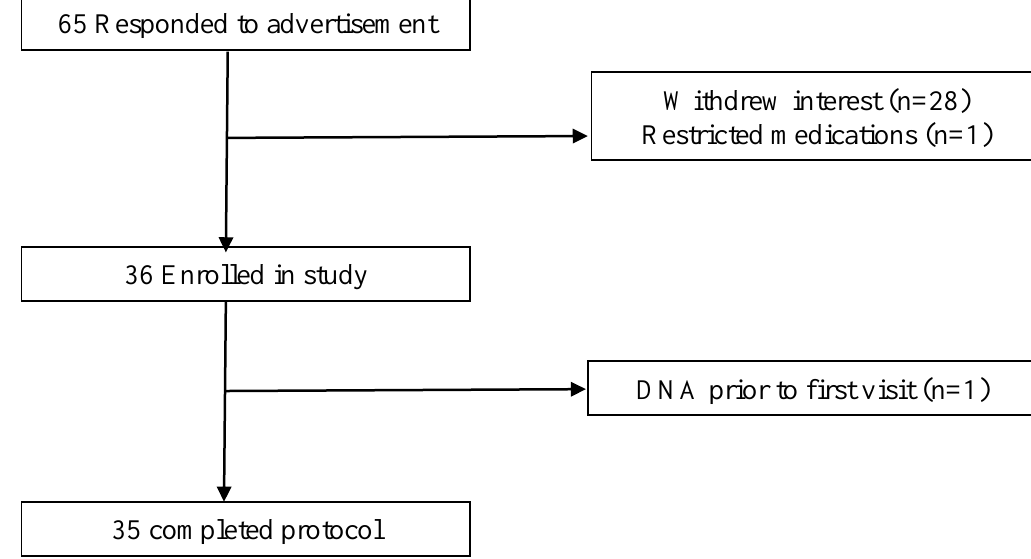
Figure 1. Consolidated standards of reporting trials diagram of the flow of subjects through the study.